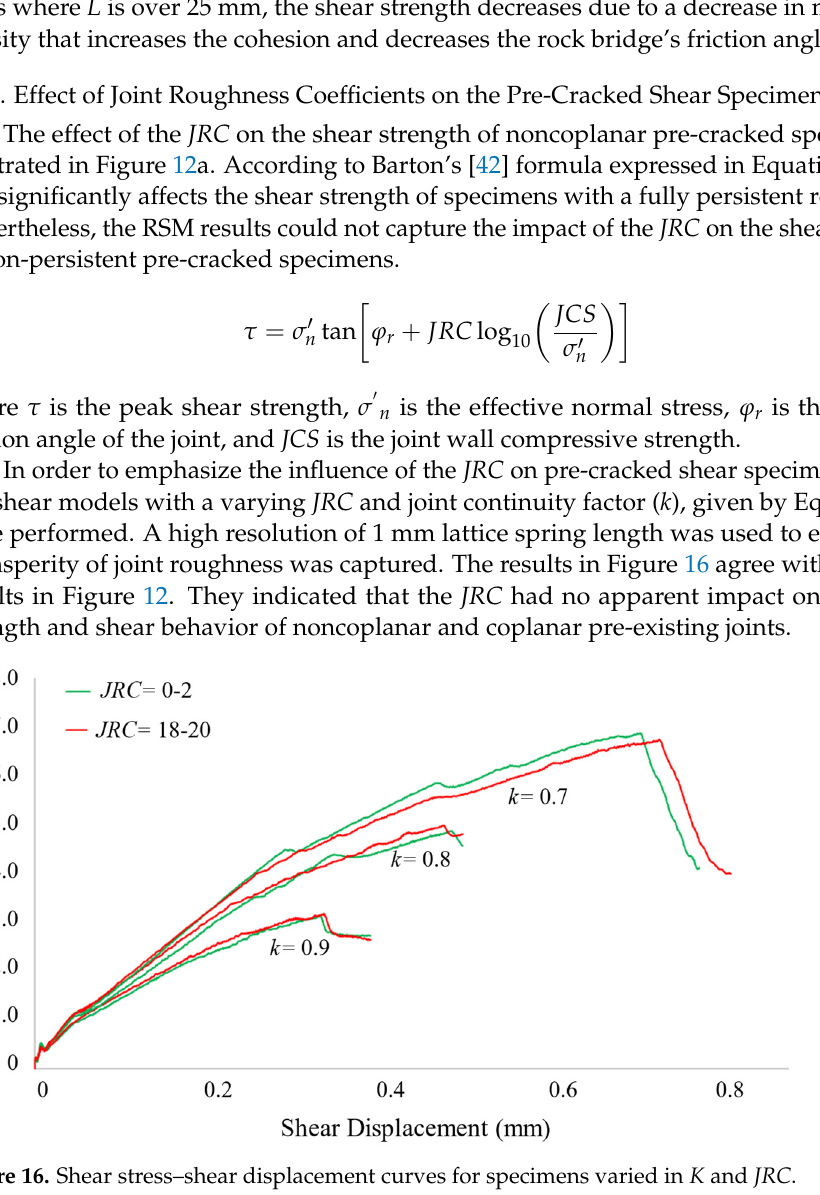
Figure 16. Shear stress–shear displacement curves for specimens varied in K and JRC